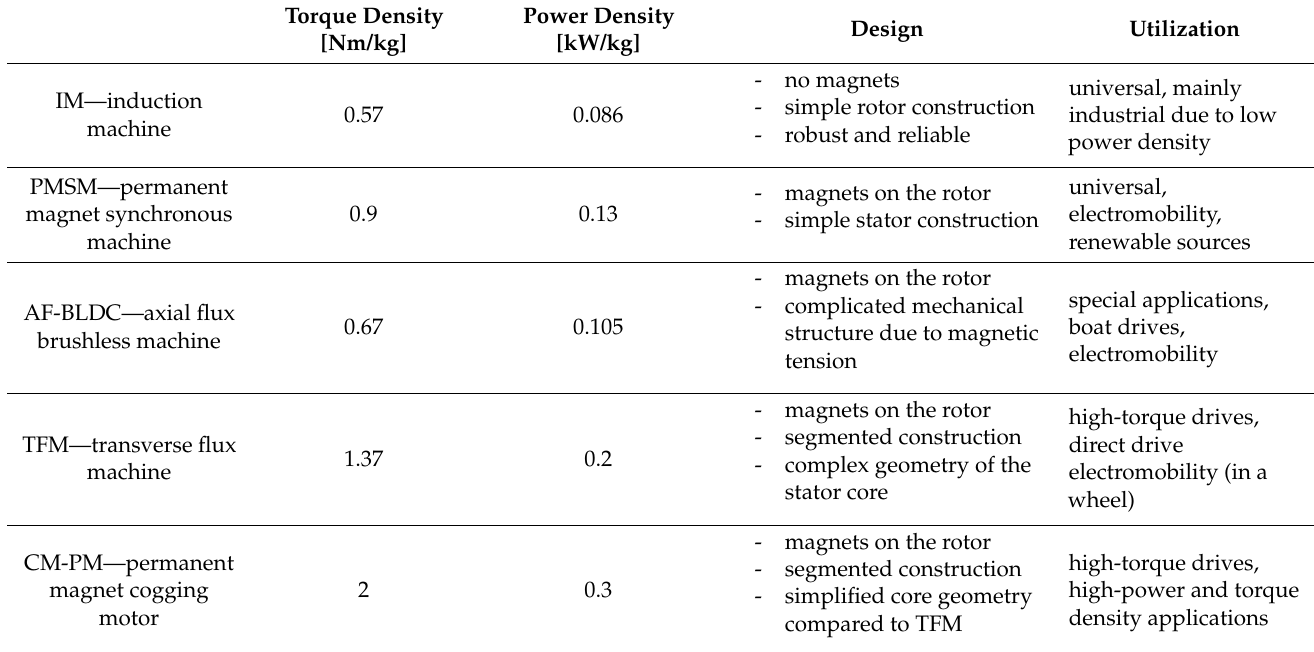
Table 1. Summary of features and parameters of various types of electric